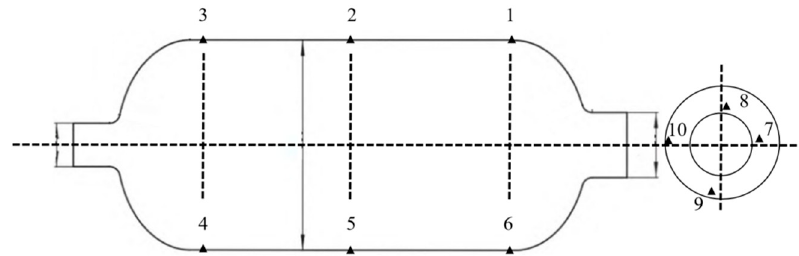
Figure 9. Stress measurement point.